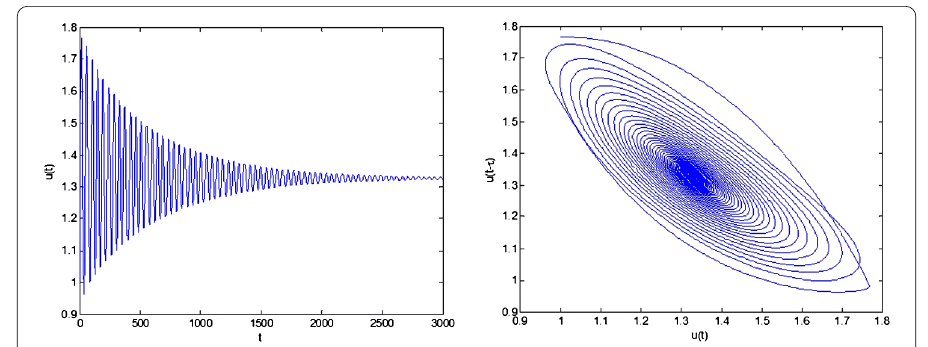
Figure 1 Waveform plot and phase portrait of the fractional-order model (2.7) with α = 0.92, m = 0.2, and the initial value u 0 = 1. The equilibrium u ∗ is asymptotically stable when υ = 18 < υ 0 = 19.6749.